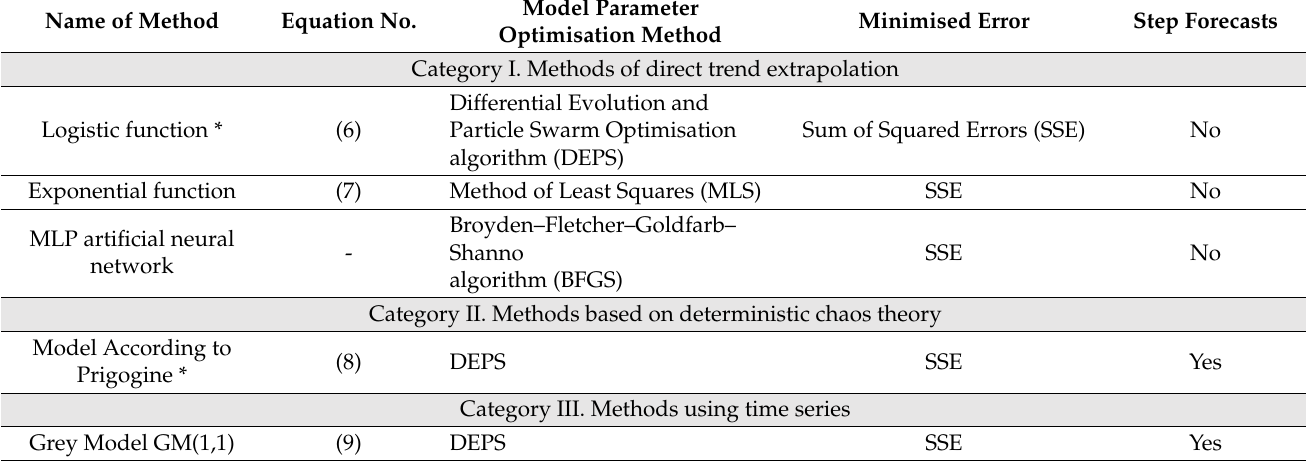
Table 1. Groups of methods used for forecasting the number of electric